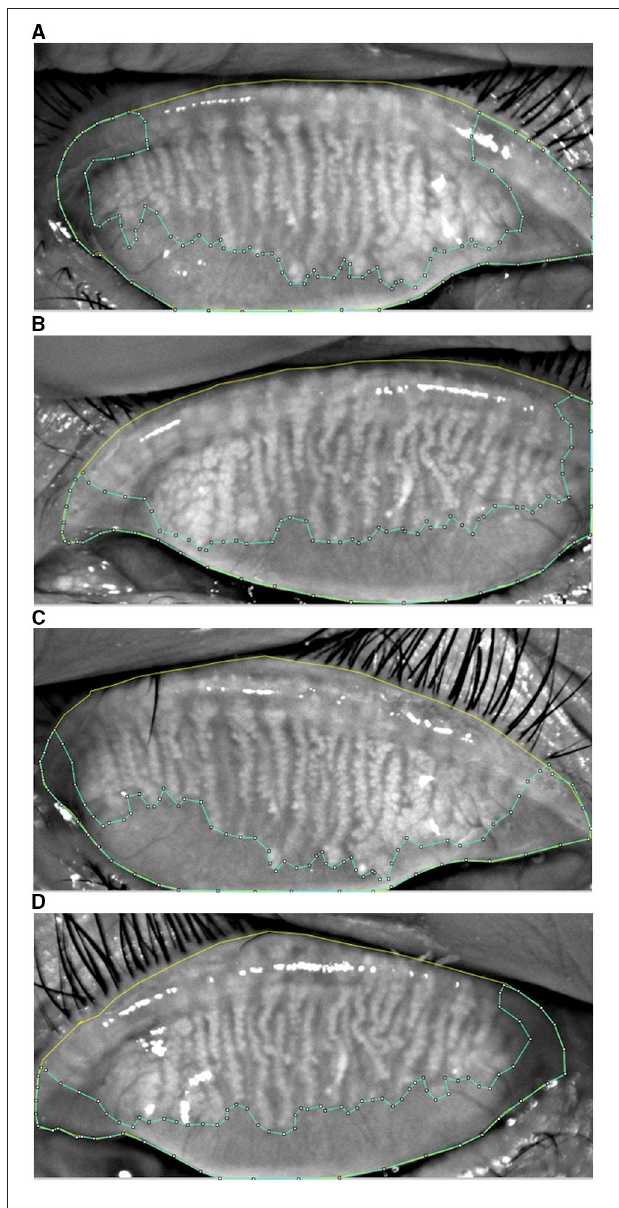
FIGURE 2 | The upper eyelid (yellow) and the edge of MG loss (blue) was drawn in the MG morphology images acquired from K5M. MG loss was calculated by the ImageJ software in the study group at baseline (A) , the control group at baseline (B) , the post-operative study group (C) , and the post-operative control group (D)